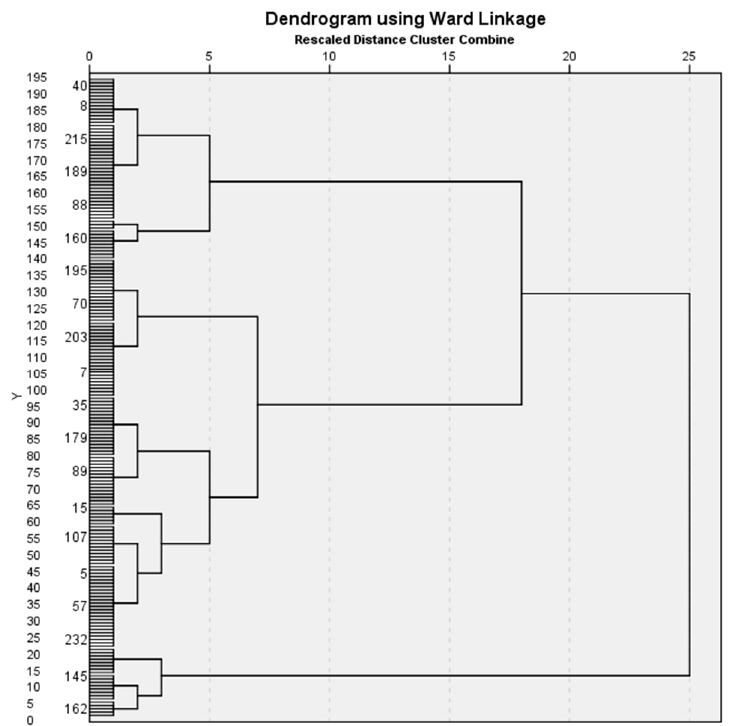
Figure 2. Dendrogram, which indicates 3 distinct main clusters.